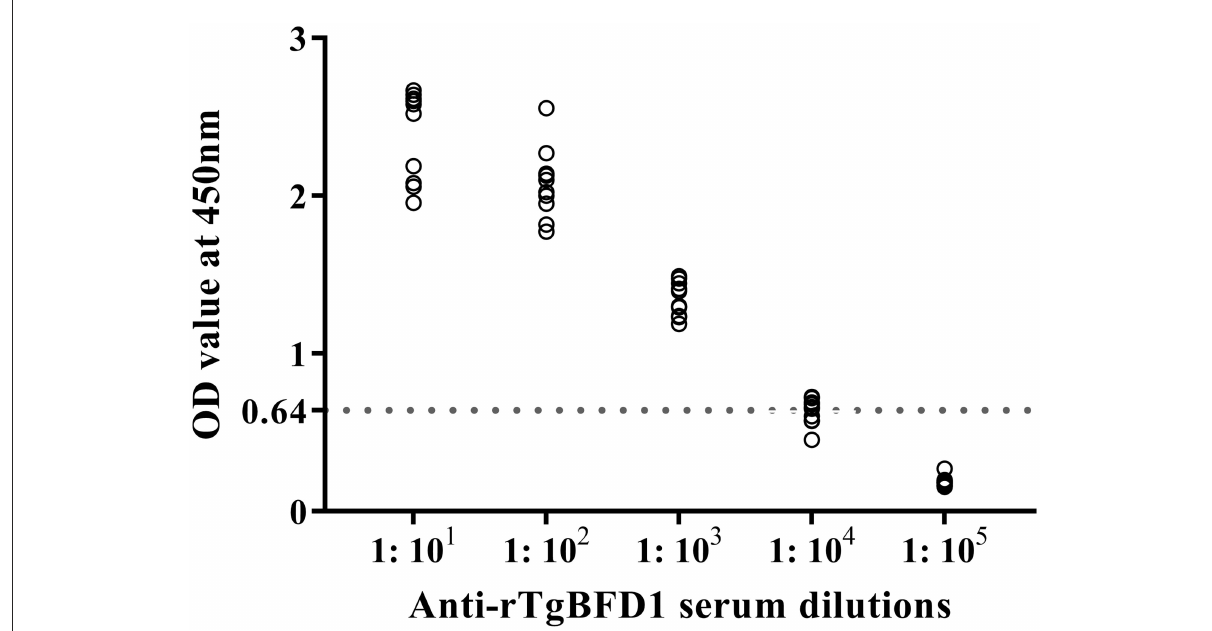
FIGURE3 Antibody titers of rTgBFD1 specific IgG antibodies detected by rTgBFD1-ELISA. Ten rTgBFD1 immunized mice sera were collected and used for rTgBFD1-ELISA while the normal mice sera served as the negative control. The dotted line represents the cutoff value at